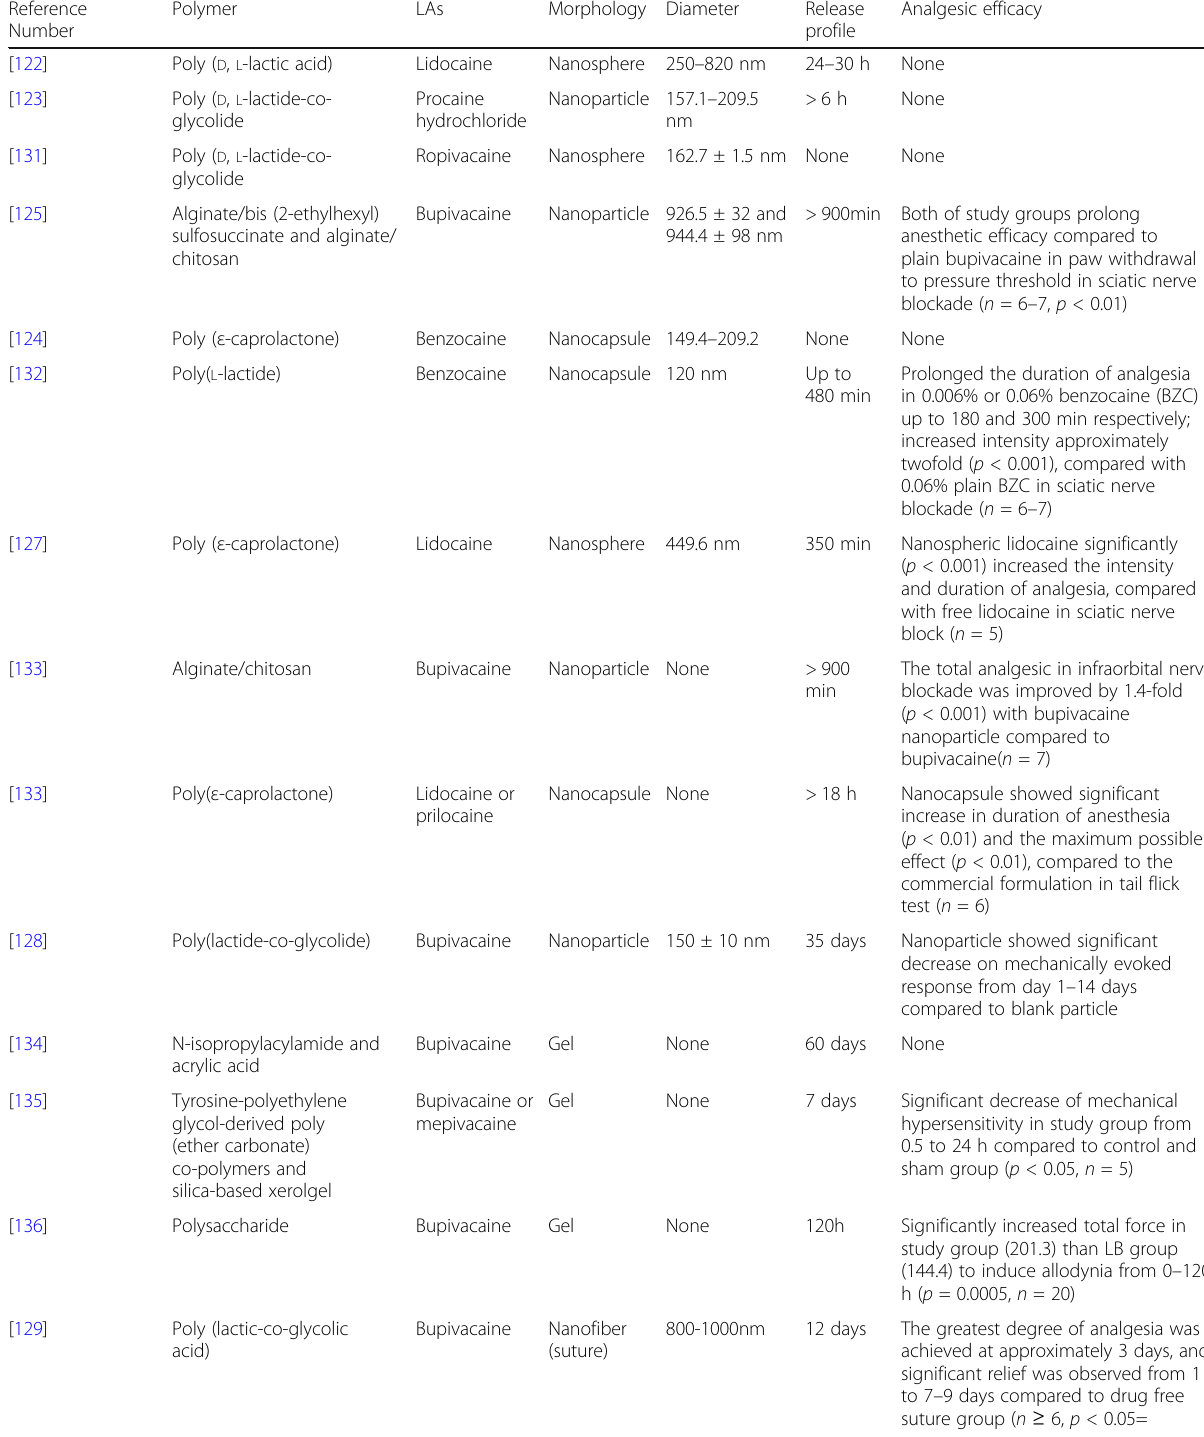
Table 4 Summary of researches on traditional polymeric LAs delivery system Reference